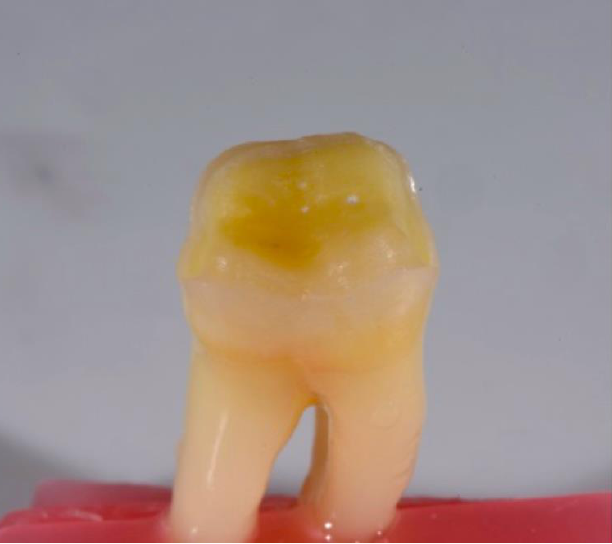
Figure 1. An example of a prepared lower molar specimen. Standardized occlusal reduction of 1.5 mm was performed following occlusal anatomy; buccal and oral finish lines with a 2 mm-long bevel were created all around the tooth.